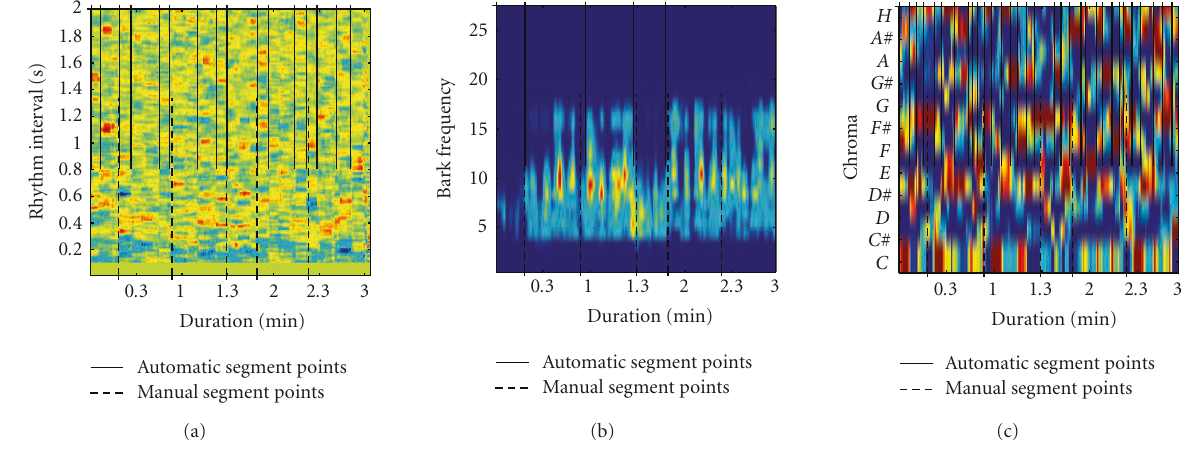
Figure 9: (a) Rhythm, (b) timbre, and (c) chroma of All of Me